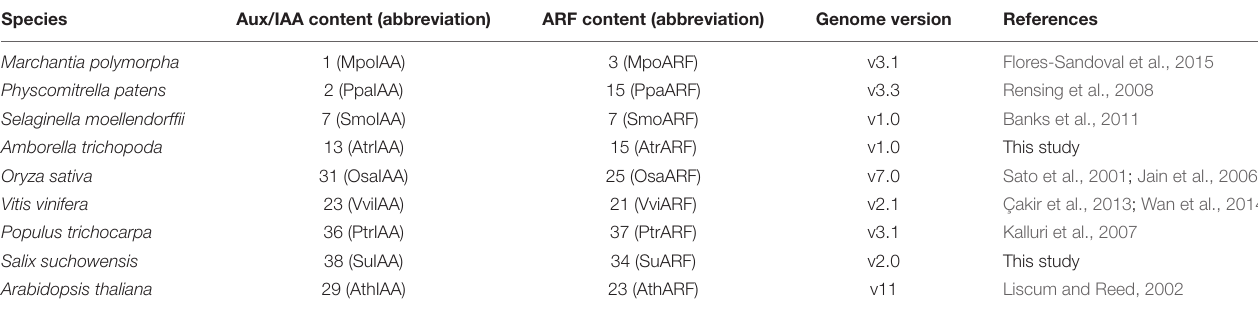
TABLE 1 | Summary of auxin/indole-3-acetic acid (Aux/IAA) and auxin response transcription factor (ARF) gene content from genomes of relevant taxonomic lineages.